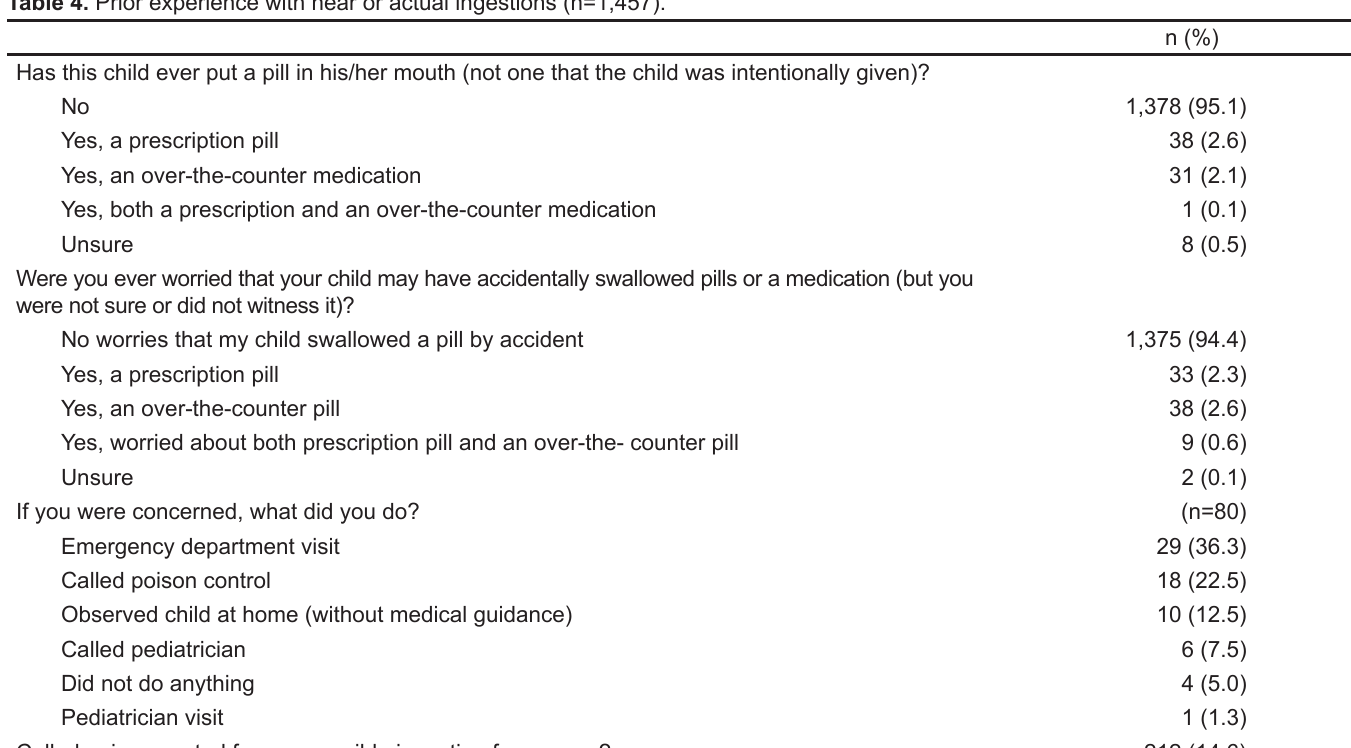
Table 4. Prior experience with near or actual ingestions (n=1,457).